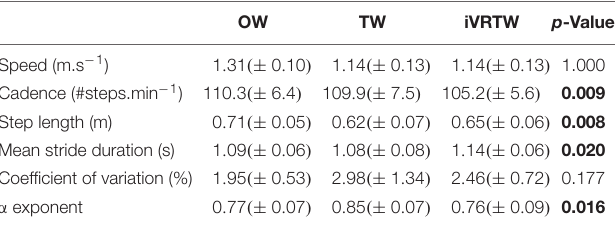
TABLE 2 | Absolute mean values of the spatiotemporal gait parameters and stride duration variability assessed during Overground Walking (OW), Treadmill Walking (TW), and immersive Virtual Reality on Treadmill Walking (iVRTW) conditions and comparison between TW and iVRTW